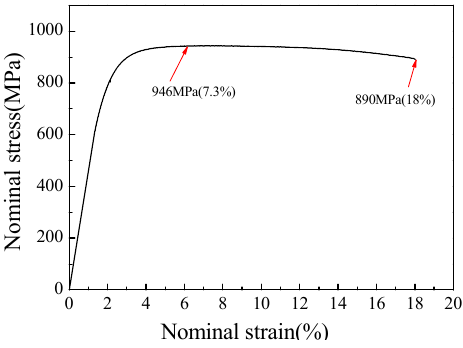
Figure 4. Engineering stress–strain curve of a multilayered steel (MLS) tensile specimen.